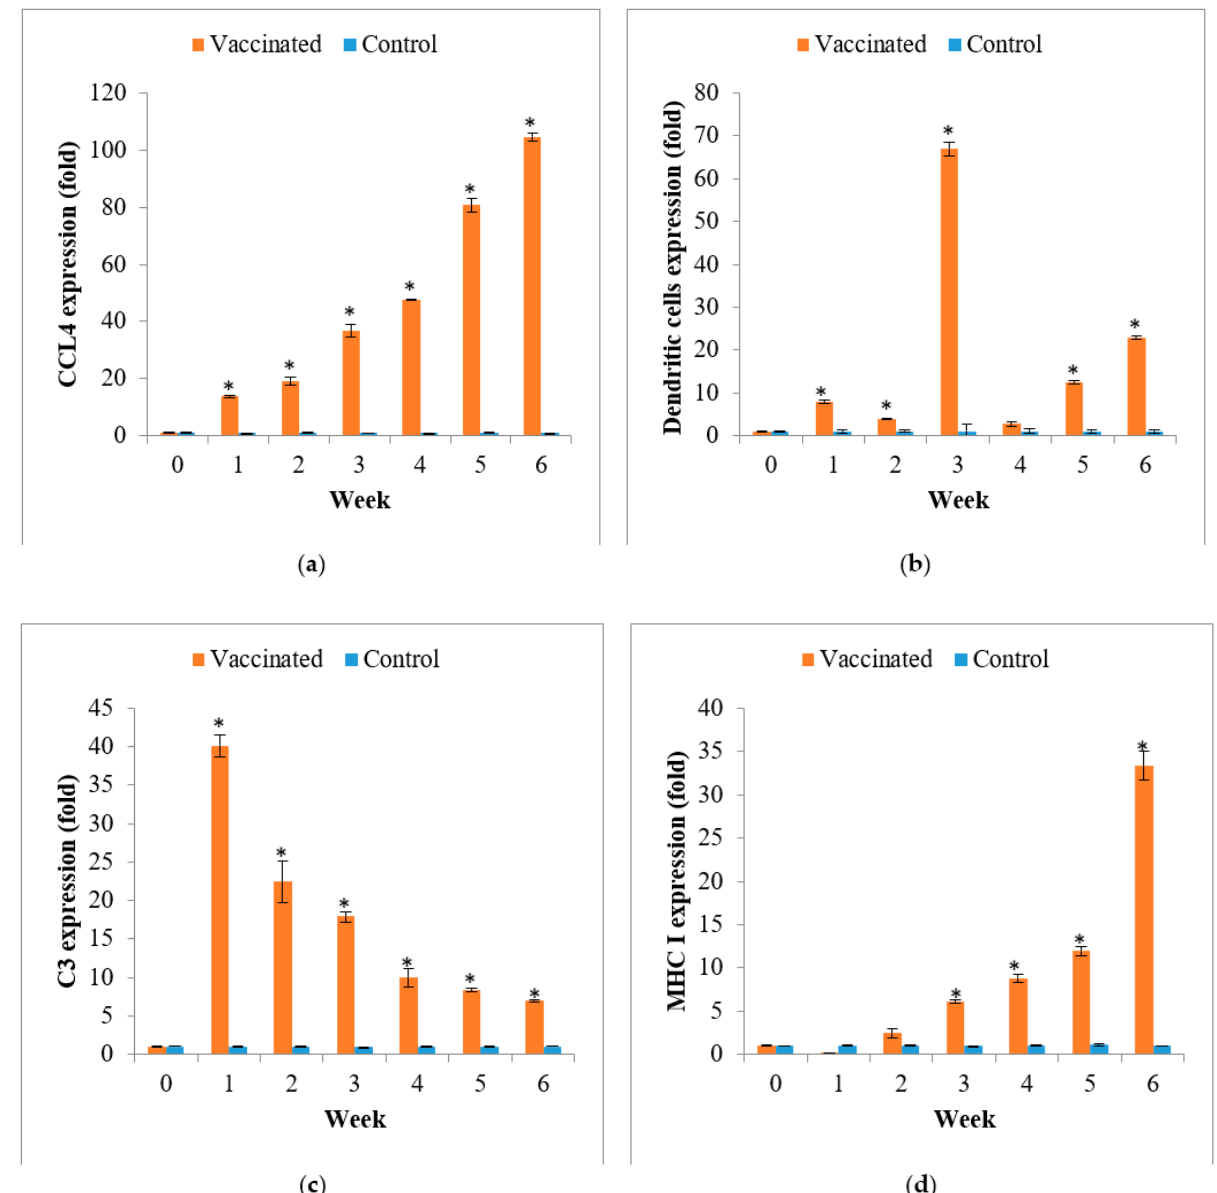
Figure 9. The relative expression of ( a ) CCL4, ( b ) dendritic cells, ( c ) C3, and ( d ) MHC I to β‐ actin in the gut after immunization in Asian seabass (mean ± SE, n = 6). Asterisks indicate a significant difference ( p < 0.05) from the control.